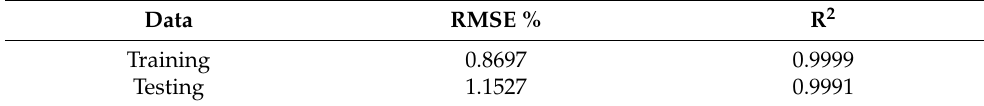
Table 3. Computed errors for the training and testing processes.